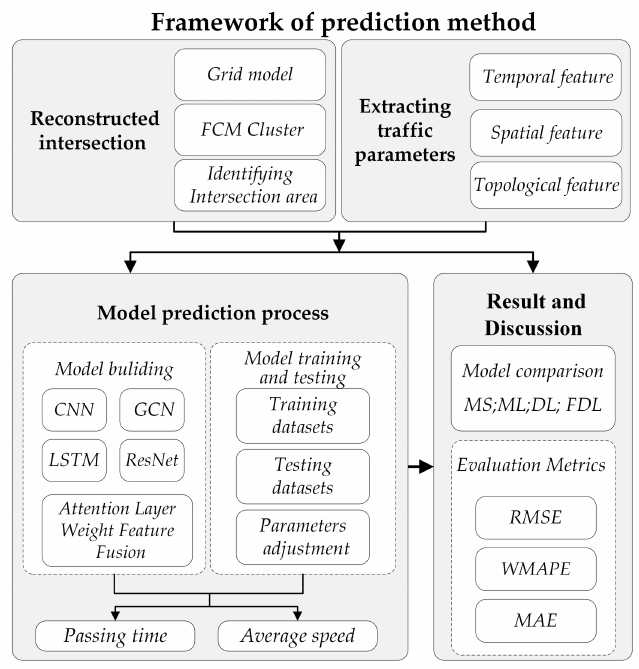
Figure 1. The flowchart of the prediction method.